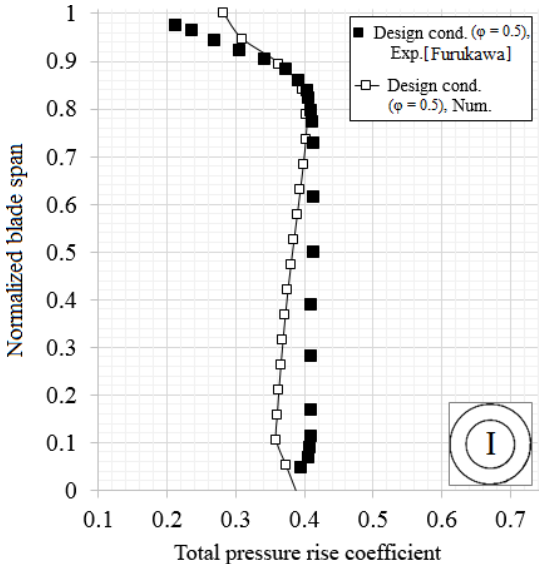
Figure 7. Comparison between present numerical total pressure rise coefficient with experimental results of Furukawa et al. (1998).